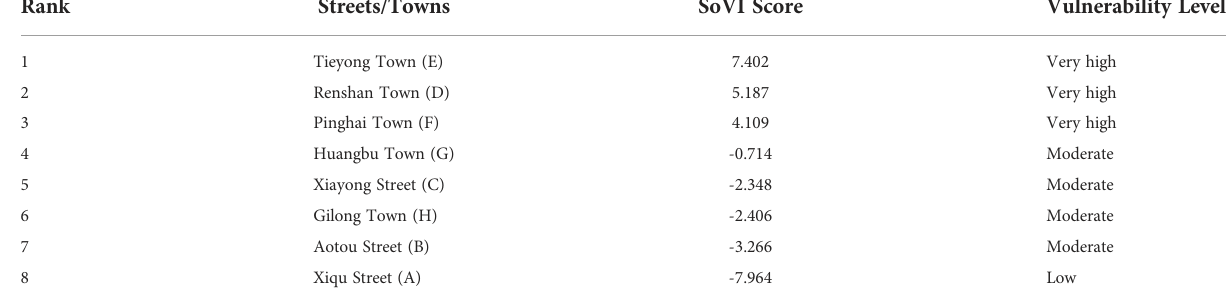
TABLE 5 SoVI scores and vulnerability levels for different streets/towns in the study area.